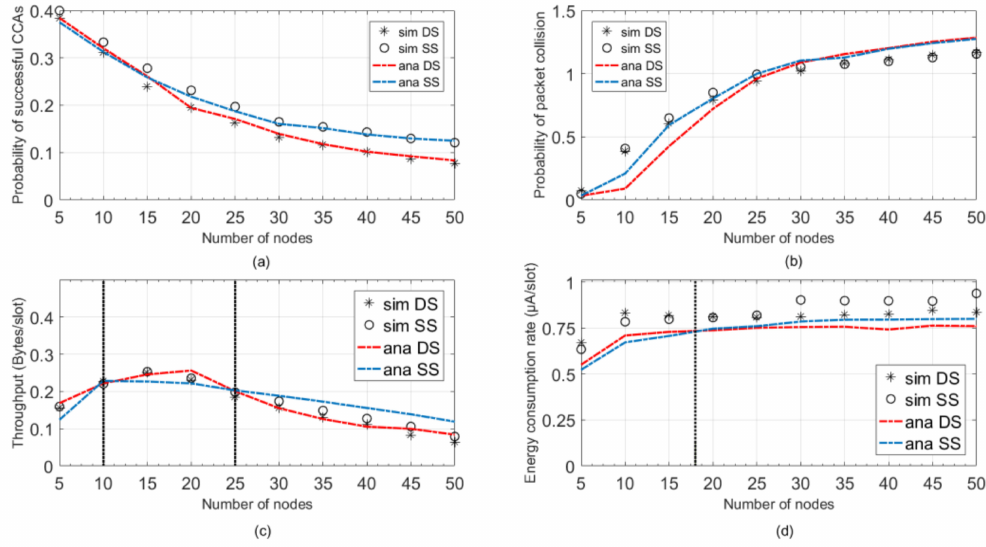
Figure 7. Comparisons between DS mode and SS mode. ( a ) Channel successful access probability P S ( b ) Packet collision probability P colli . ( c ) Aggregate throughput S . ( d ) Energy consumption e